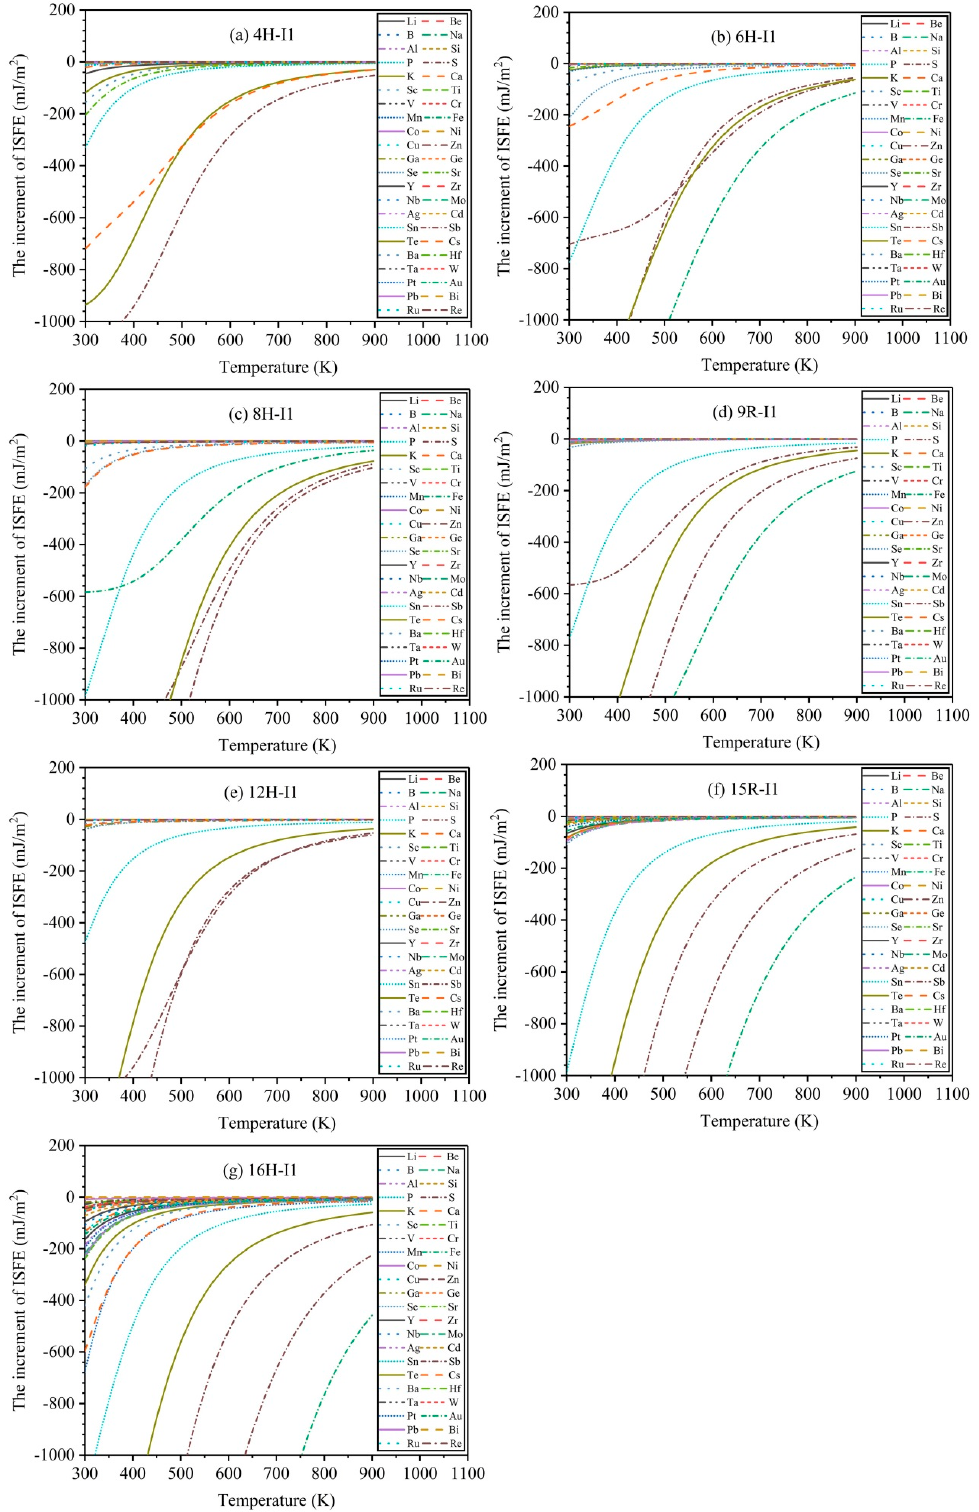
Figure 6. Variation curves of the increments of ISFEs as a function of finite temperature T at c 0 = 0.1%: ( a – g ) denote 4H, 6H, 8H, 9R, 12H, 15R, and 16H phases, respectively.